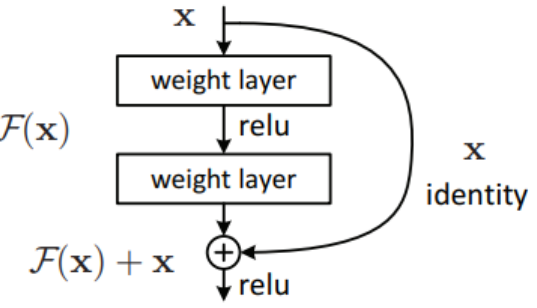
Figure A1. Residual learning: a building block. Source: [15], used with